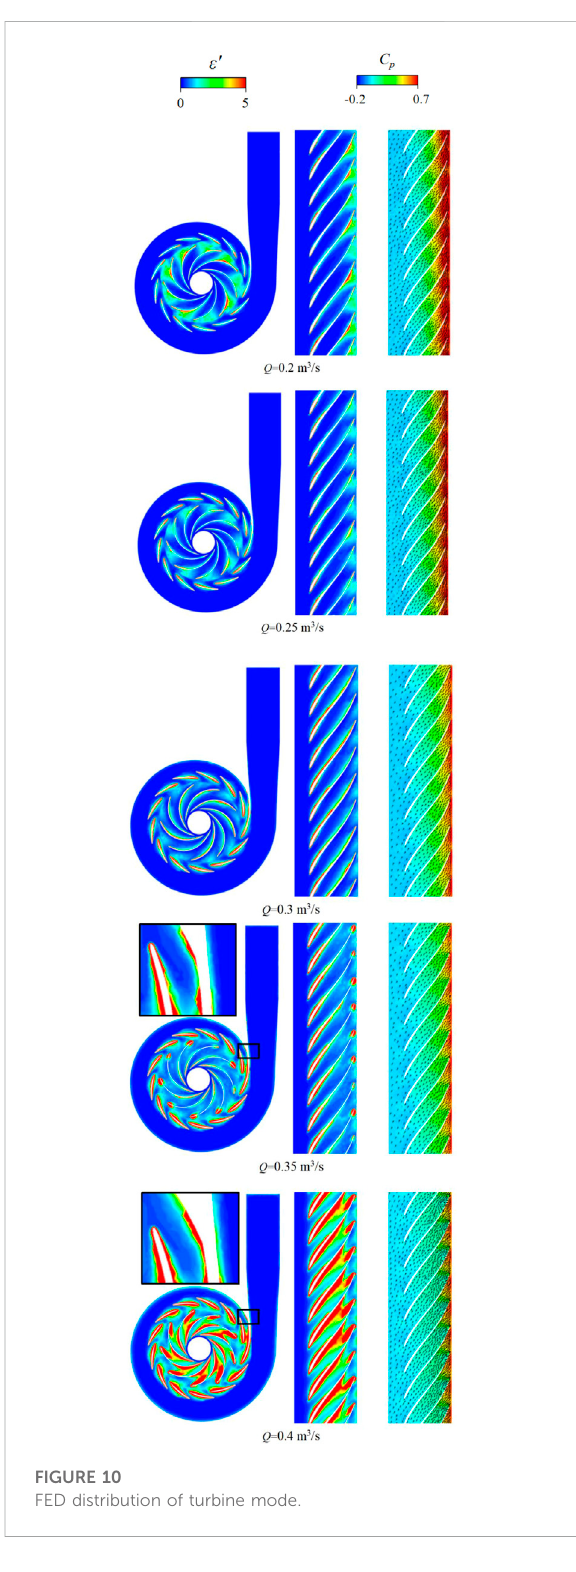
FIGURE 10 FED distribution of turbine